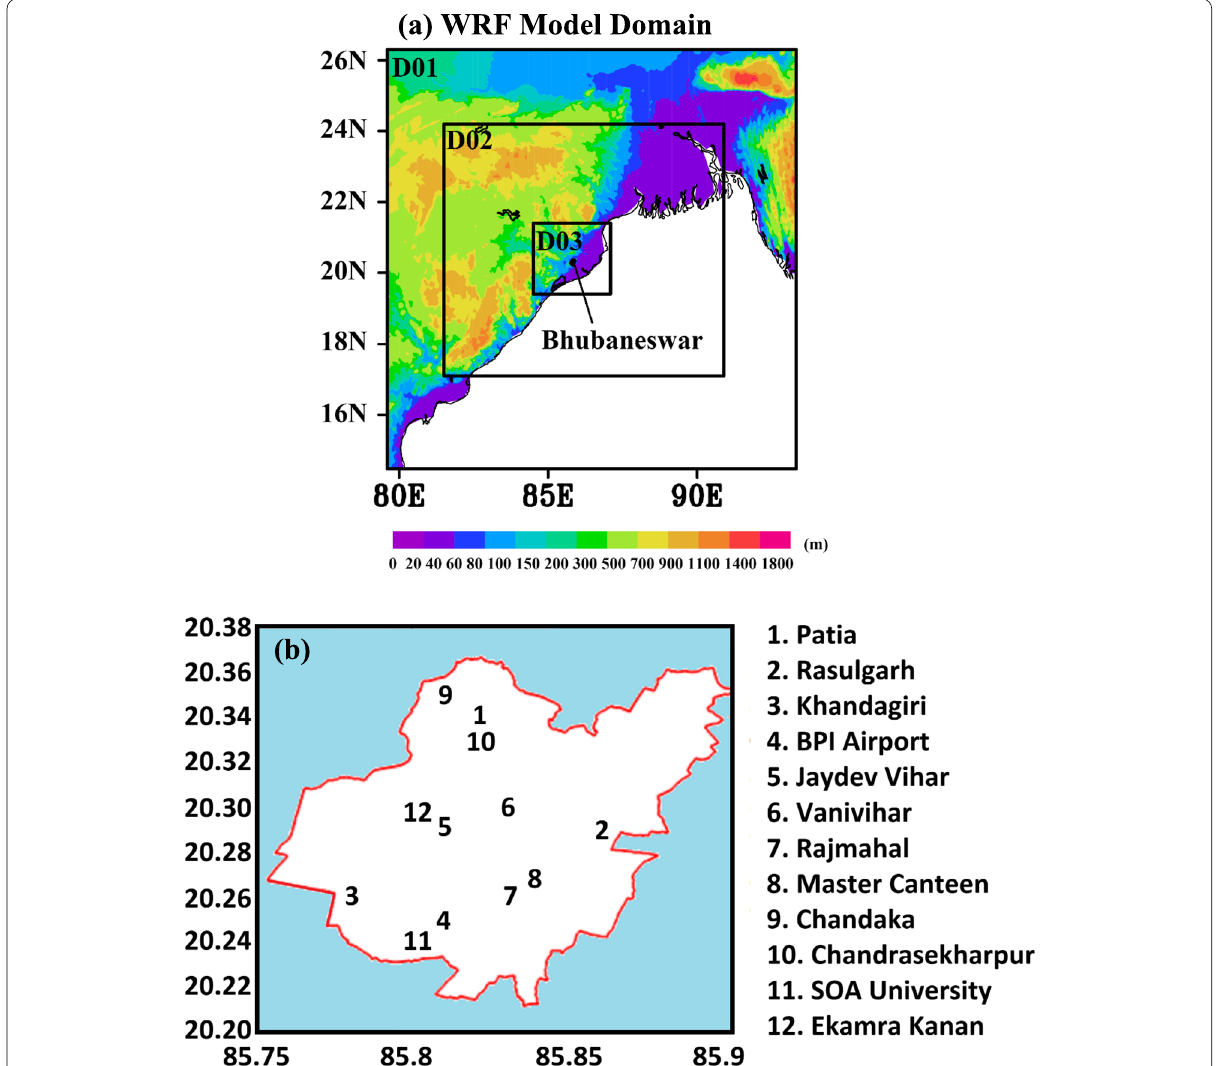
Fig. 2 a WRF Model domain setup used in the study. The background shows the terrain height (m). b Bhubaneswar municipal with the numbers indicating the landmarks of surface meteorological stations across Bhubaneswar